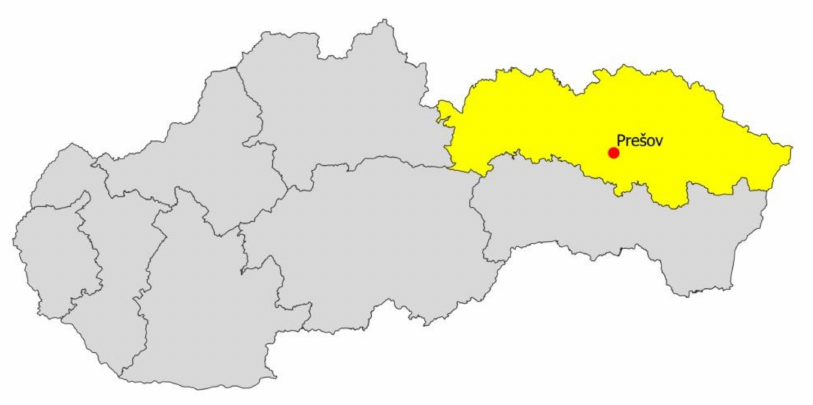
Figure 1. Prešov